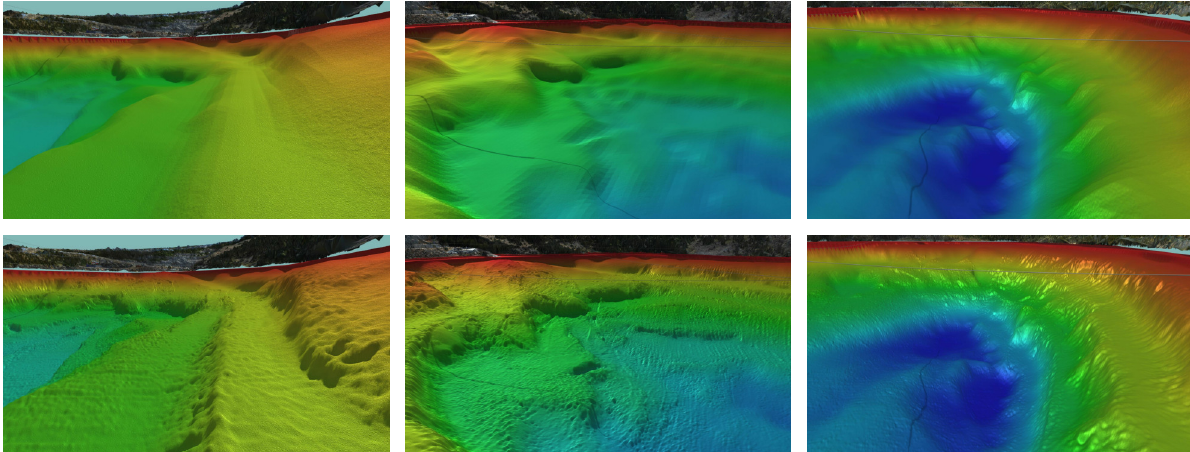
Figure 8. Bathymetry of the Silvermines flooded opencast mine. Top: pre-survey created by a surveyor, bottom: updated survey created using multibeam